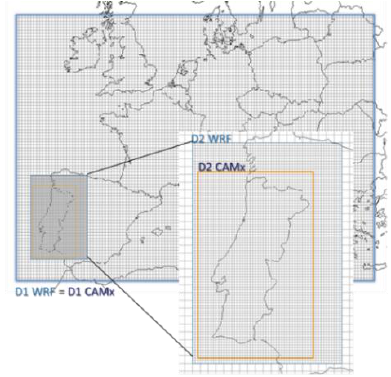
Figure 2. Modelling domains for WRF and